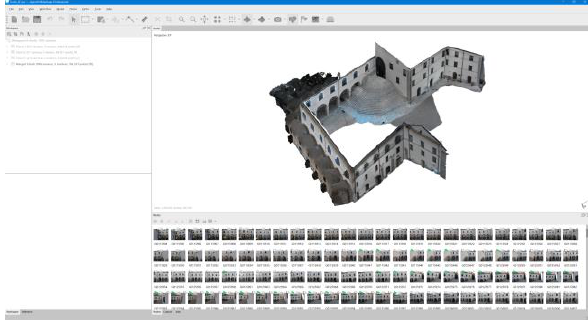
Figure 4. Metashape texture model.